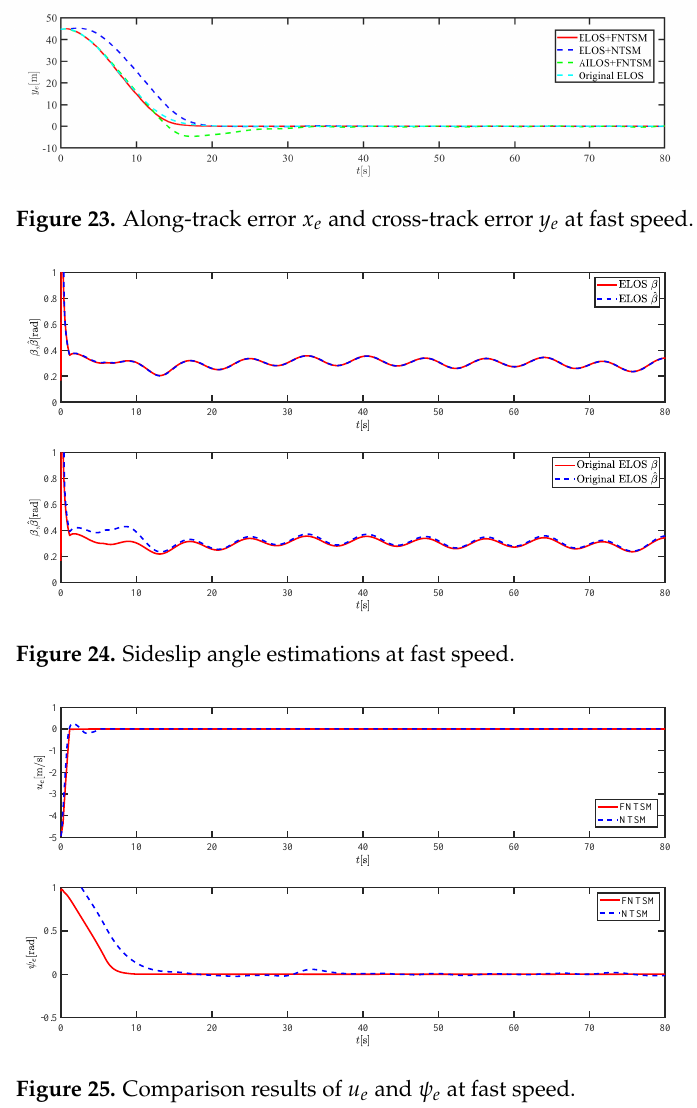
Figure 25. Comparison results of u e and ψ e at fast